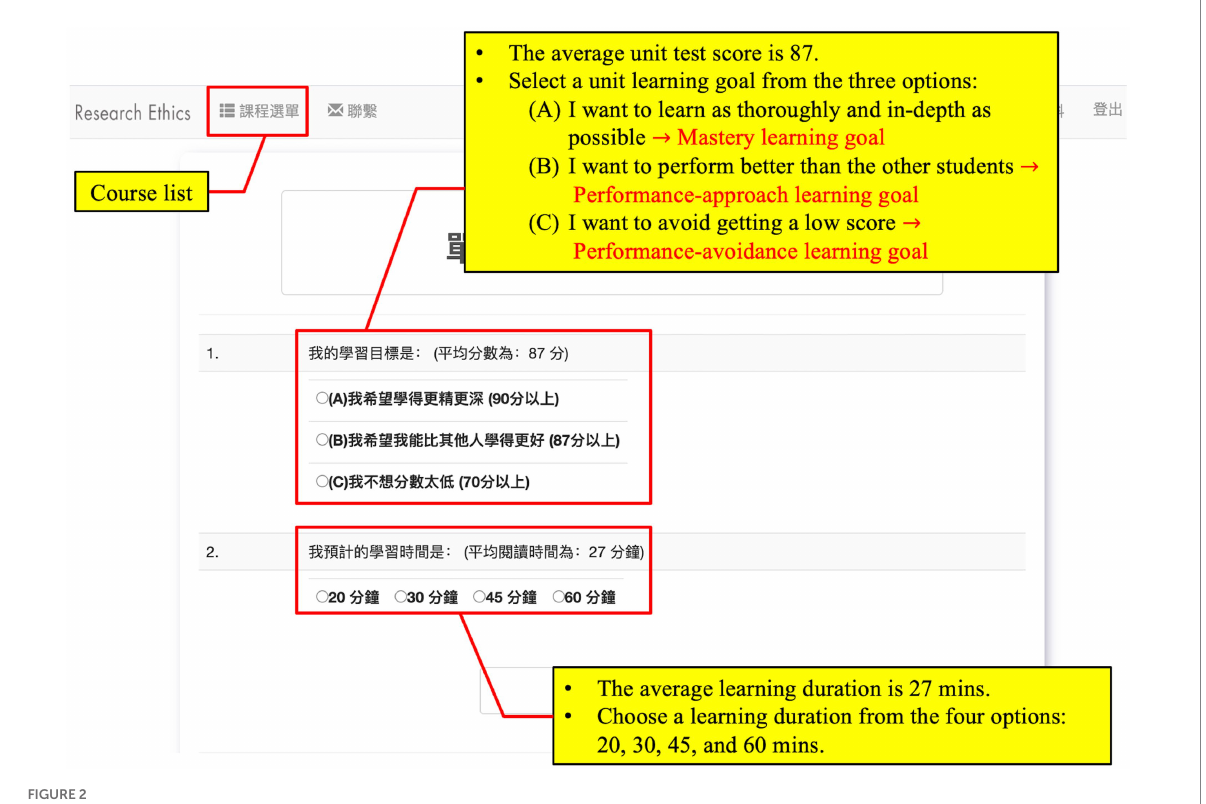
FIGURE 2 The user interface for goal and duration